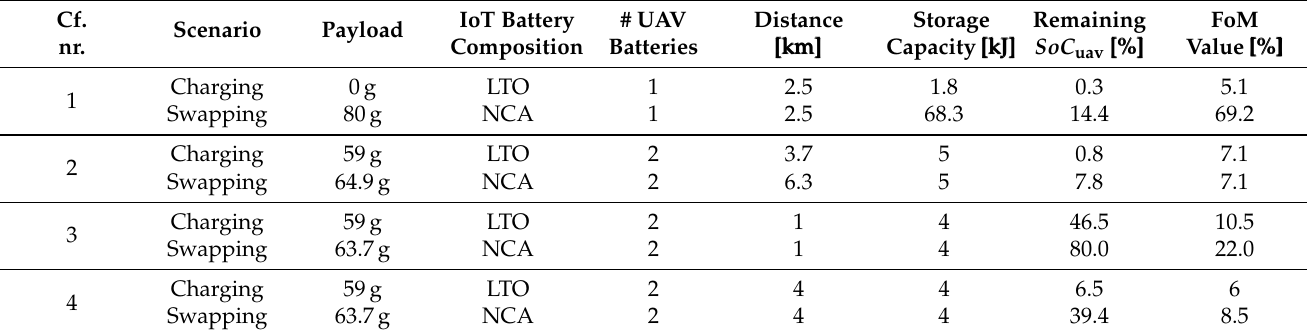
Table 5. Comparison of FoM values for different scenarios.